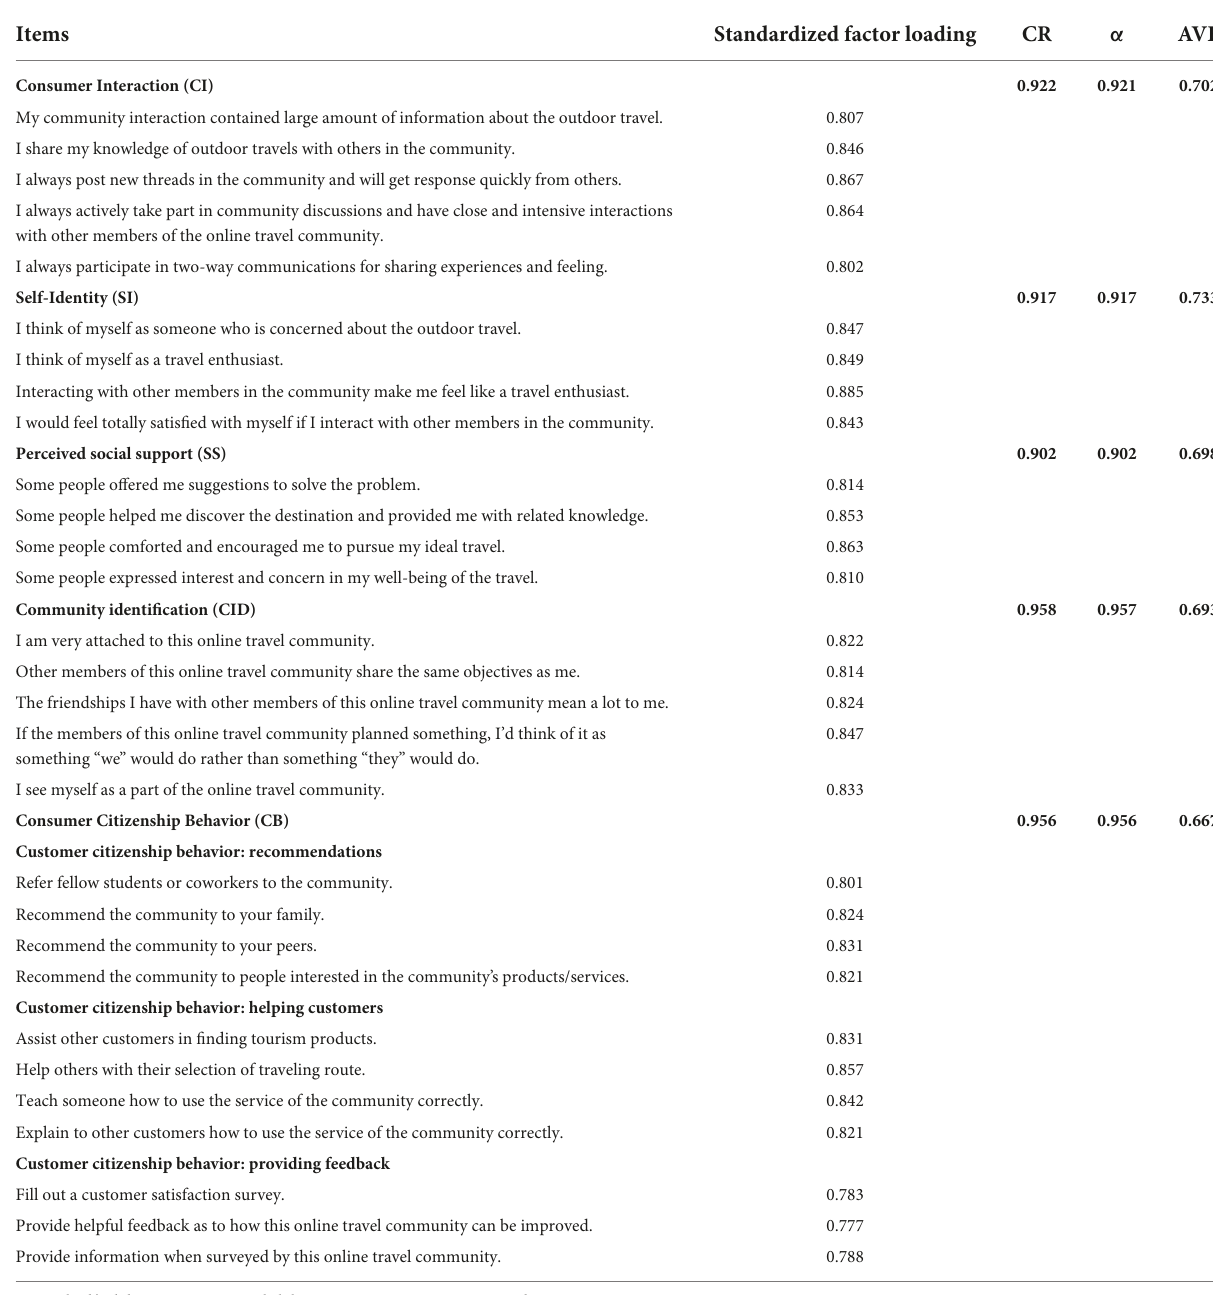
TABLE 2 Measure items, the reliability, and convergent